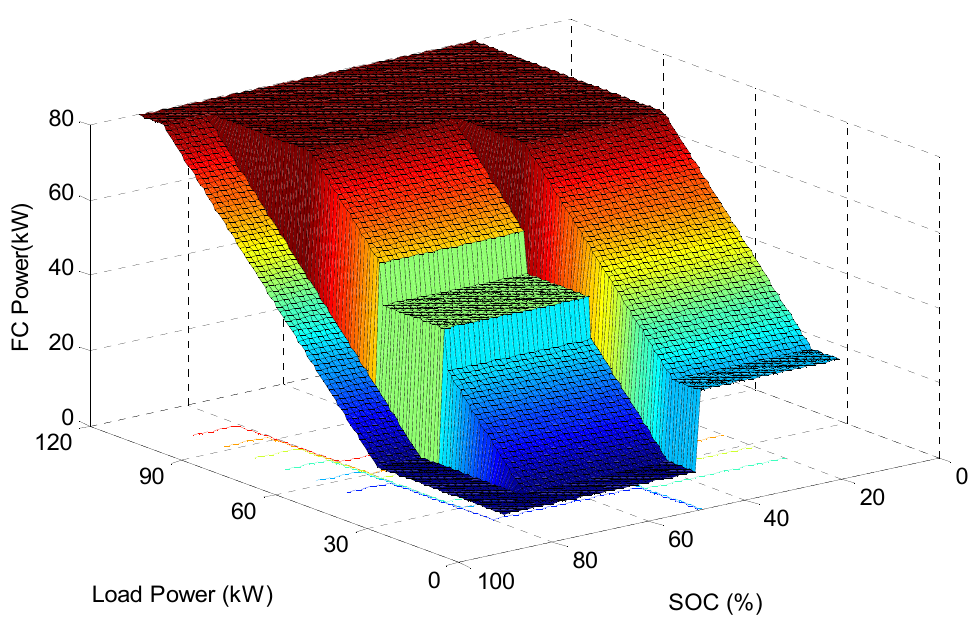
Figure 9. Power map of